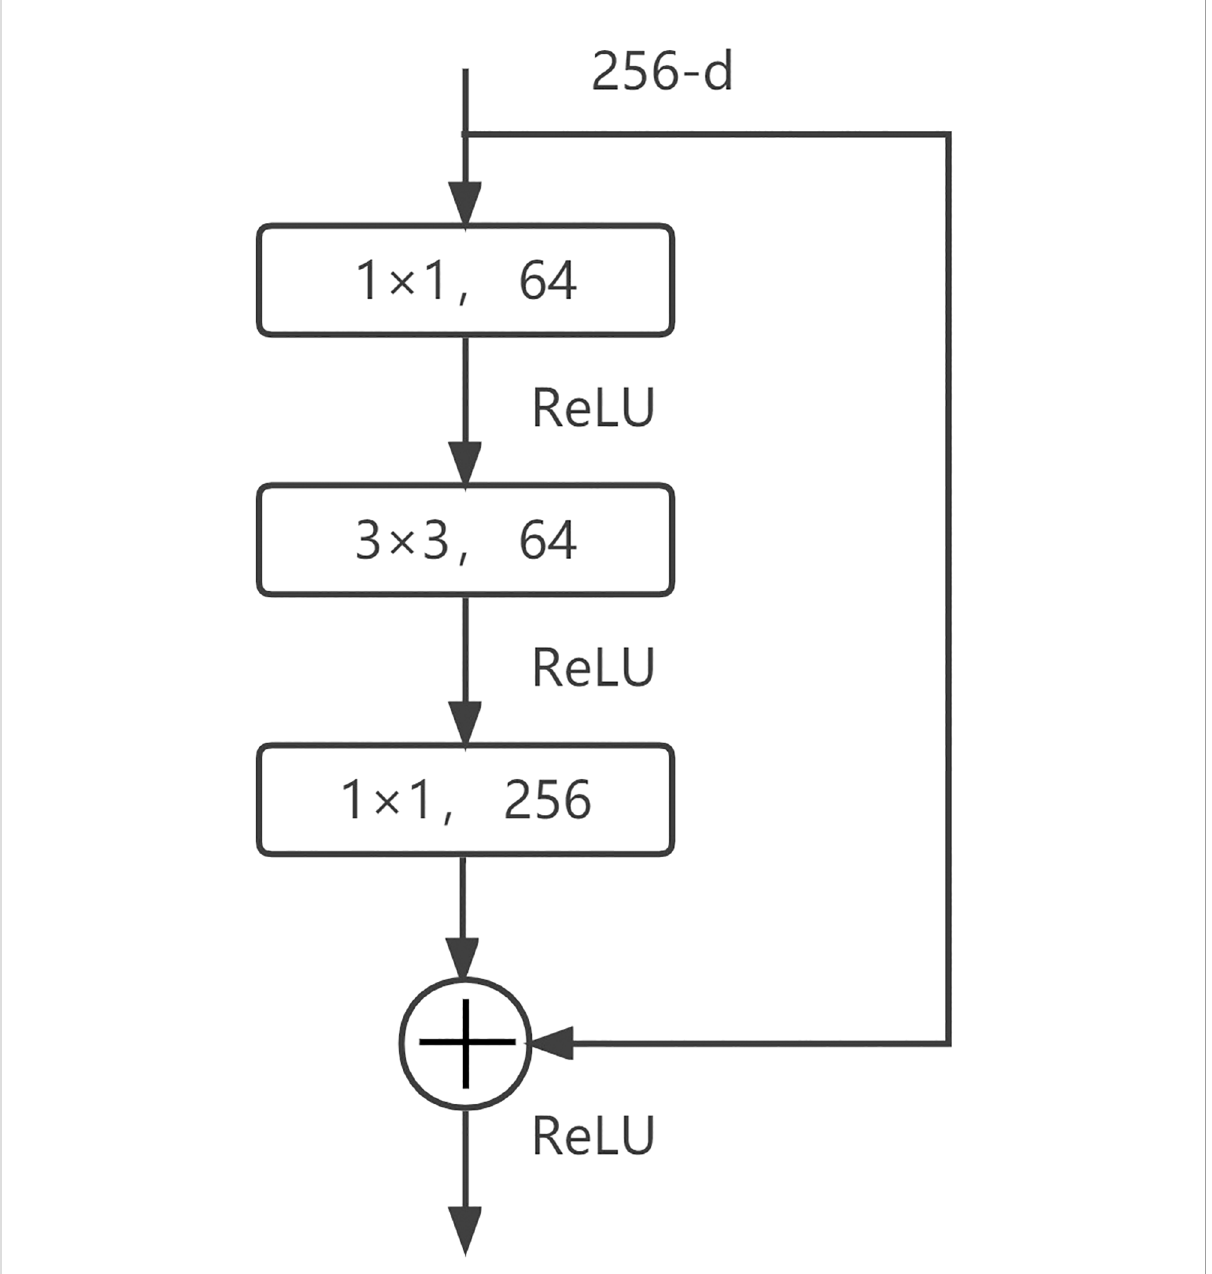
FIGURE 4 ResNet residual module. ReLU, Recti fi ed Linear